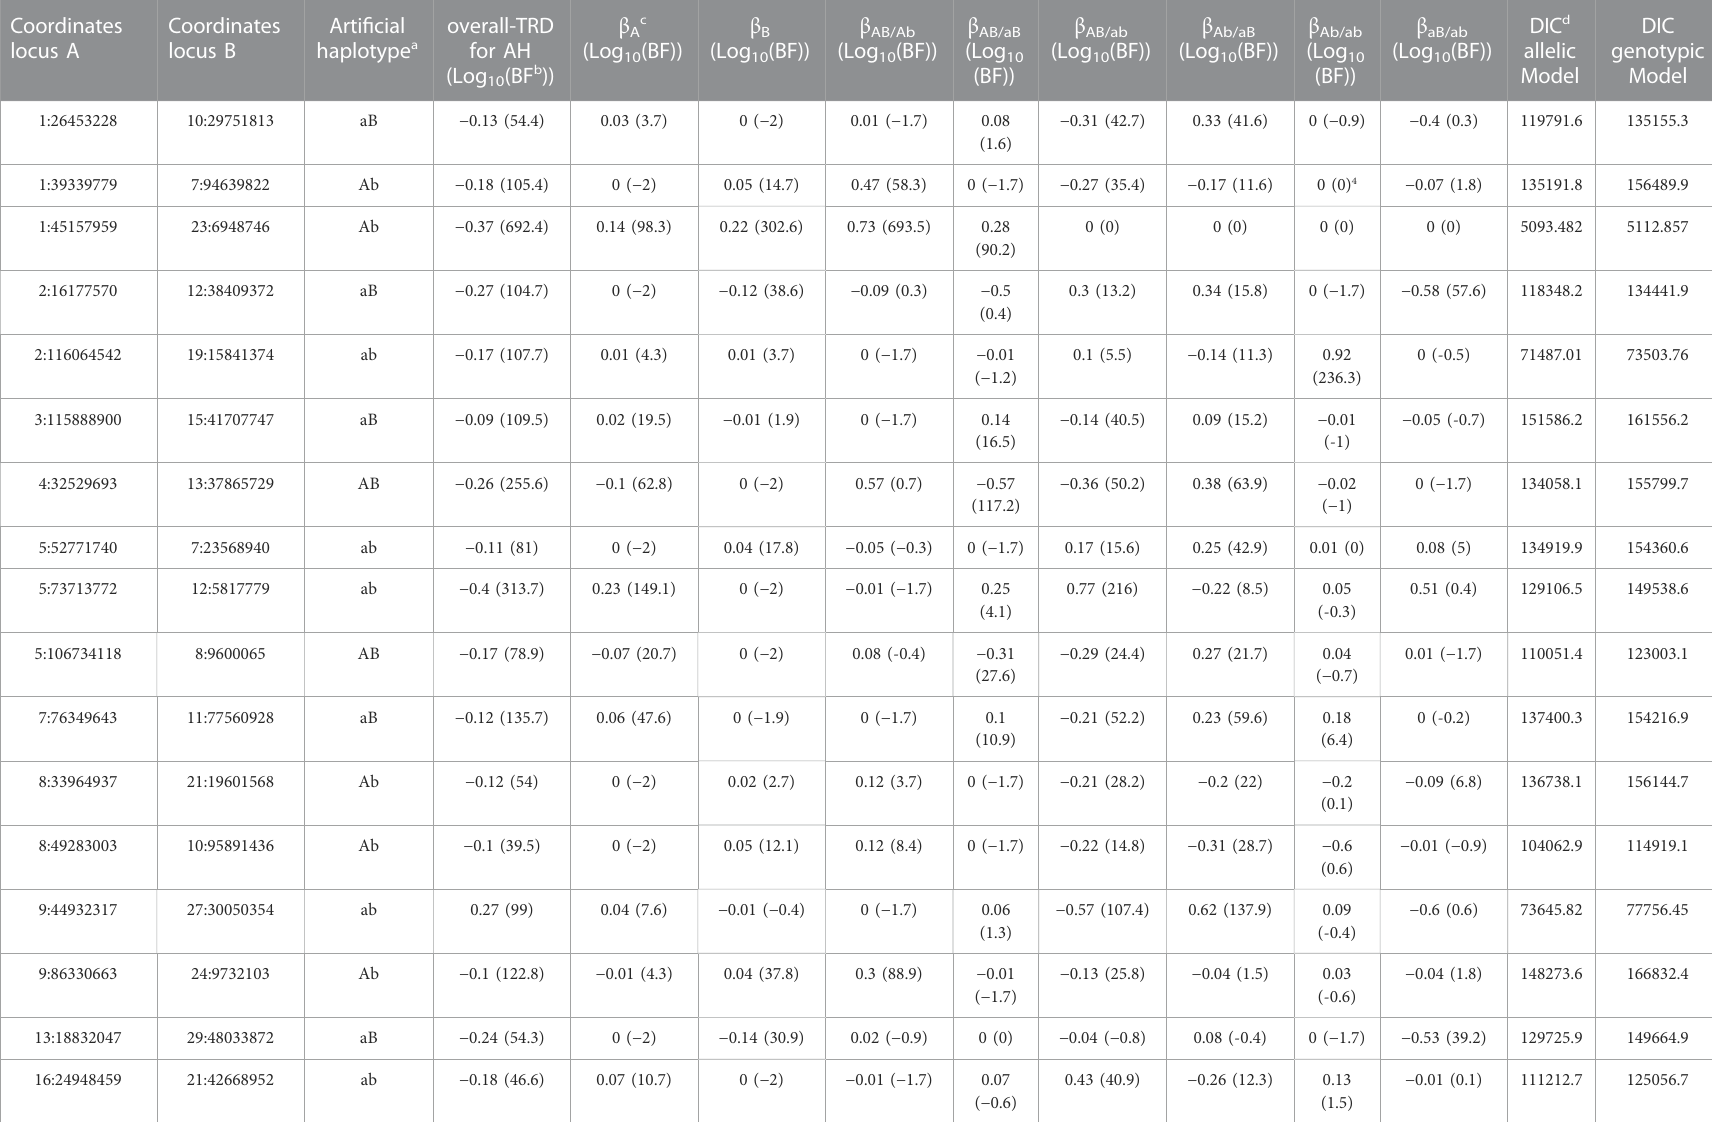
TABLE 3 Pairs of genomic regions identi fi ed with epistatic transmission ratio distortion (TRD) in Holstein cattle with allelic patterns. Coordinates locus